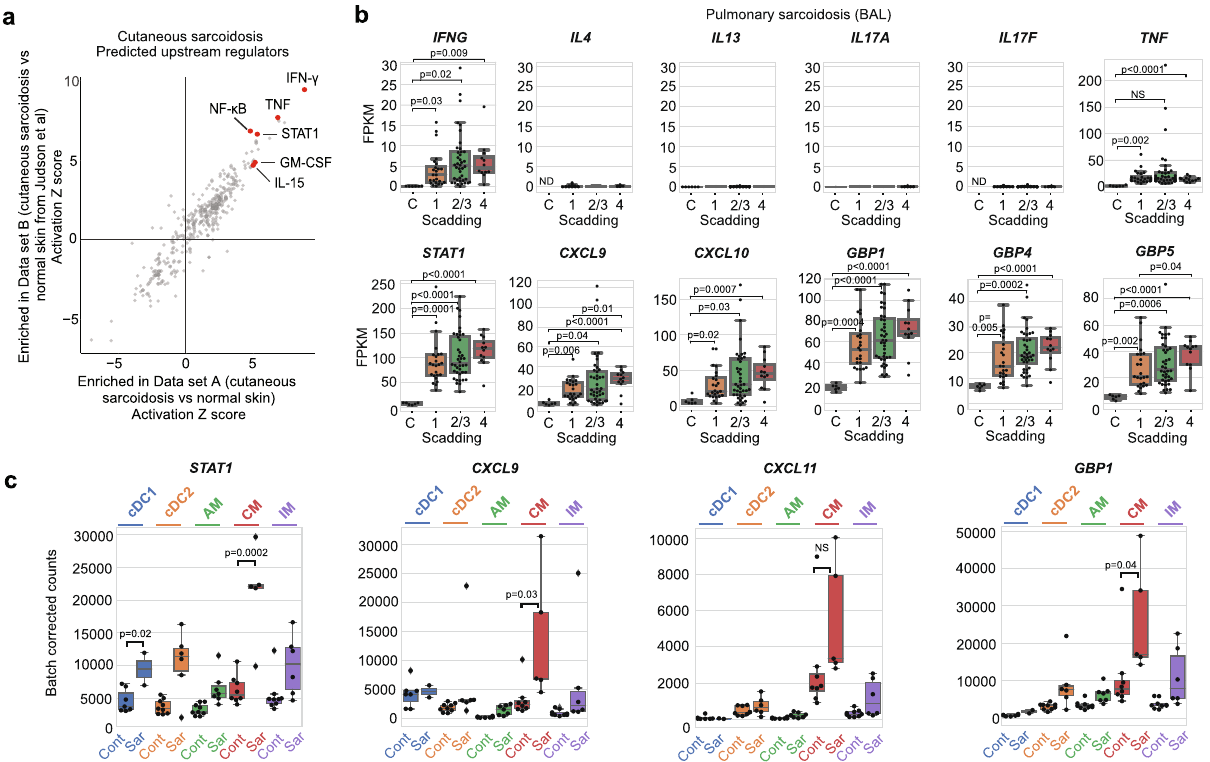
Fig. 6 IFN- γ signaling is a hallmark of sarcoidosis. a IPA analysis showing predicted upstream regulators in cutaneous sarcoidosis dataset A (bulk RNAseq from this study) and cutaneous sarcoidosis dataset B (Judson et al); 31 IPA content version: 51963813). Each data set consisted of a series of cutaneous sarcoidosis biopsies and normal control skin. b Box and whisker plots showing expression of selected genes in pulmonary sarcoidosis with Scadding stage 1 ( n = 24), stage 2/3 ( n = 40), stage 4 ( n = 12) relative to healthy controls (C) ( n = 6) 33 . Box plots indicate median (middle line), 25th, 75th percentile (box), and 5th and 95th percentile (whiskers), p values calculated using unpaired t tests, NS: not signi fi cant, ND: not determined (abundance below threshold of detection), FPKM: fragments per kilobase of exon per million mapped fragments. See also Supplementary Fig. 5. c Box and whisker plots showing expression of selected genes in various populations of FACS puri fi ed myeloid cells from BAL of healthy controls ( n = 9) (Cont) vs sarcoidosis ( n = 8) (Sar) 34 . Box plots indicate median (middle line), 25th, 75th percentile (box), and 5th and 95th percentile (whiskers), p values calculated using unpaired t tests, NS: not signi fi cant, cDC1 and 2: classical dendritic cell types 1 and 2, AM: alveolar macrophage, CM: classical monocyte, IM: intermediate monocyte. (See also Supplementary Fig. 6). Source data are provided as a Data Source